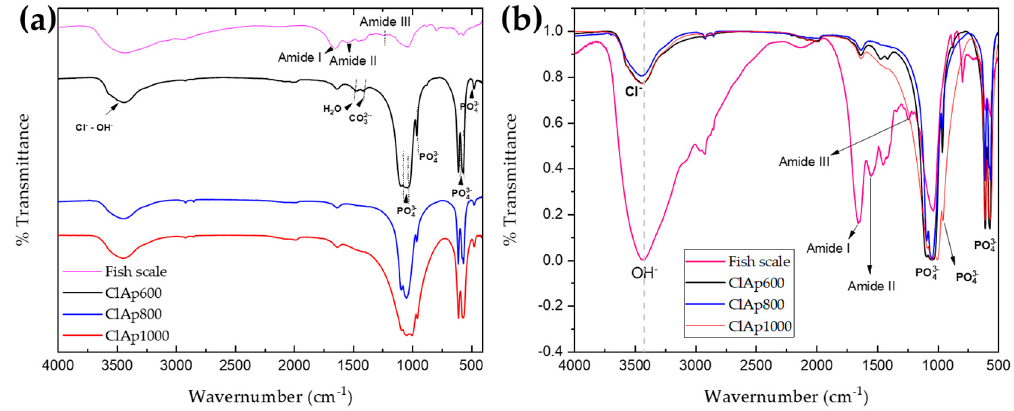
Figure 5. FTIR spectrum of calcined powders and FS: ( a ) Normalized spectrums; ( b ) Spectrum with real y-axis.